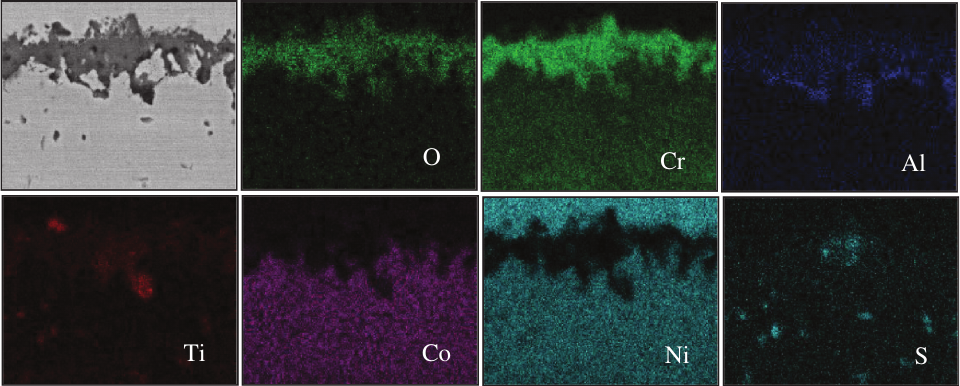
Figure 6: EDS elemental mapping analysis of the corroded samples at 750°C for 500h with 0.1% SO 2 addition.